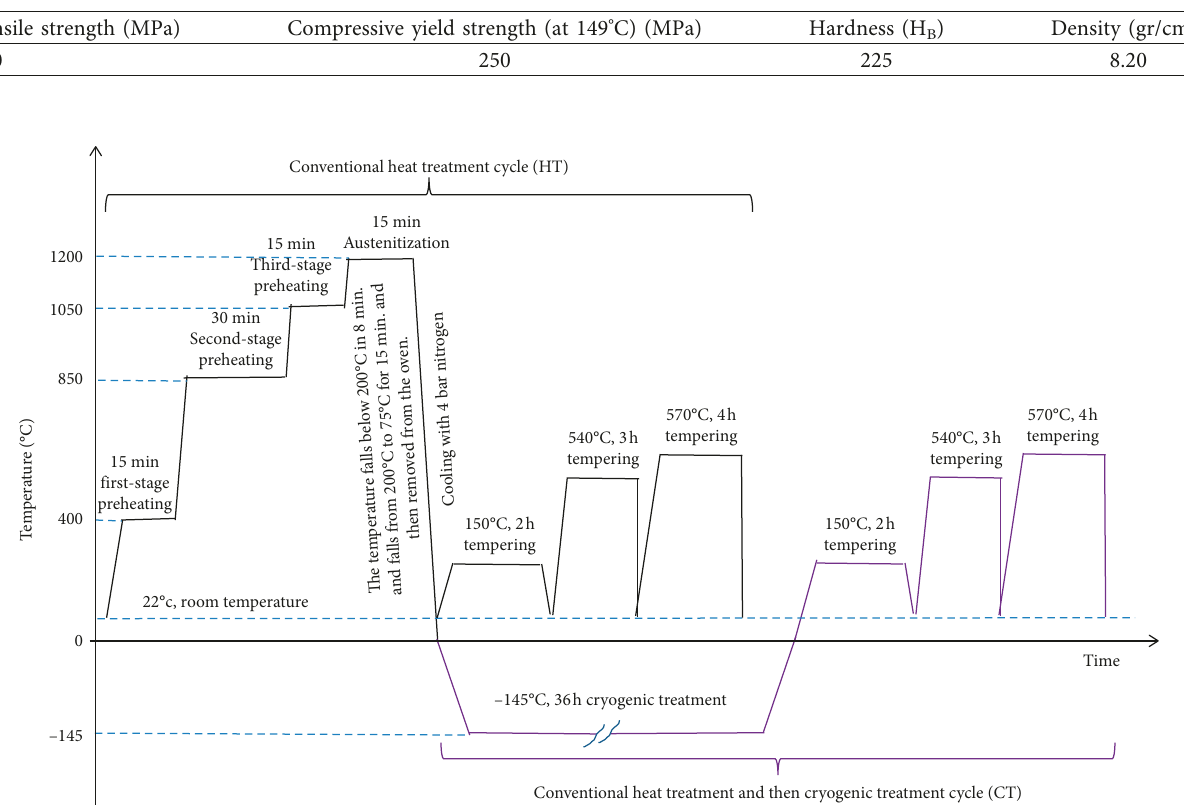
Table 4: The strength values of M2 steel (by the tool